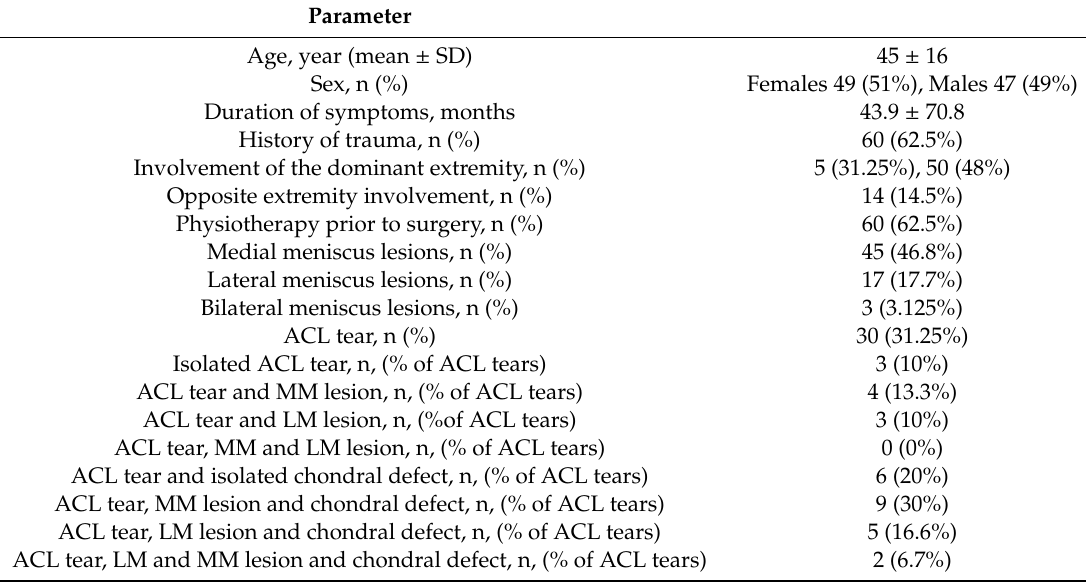
Table 1. Clinical and baseline